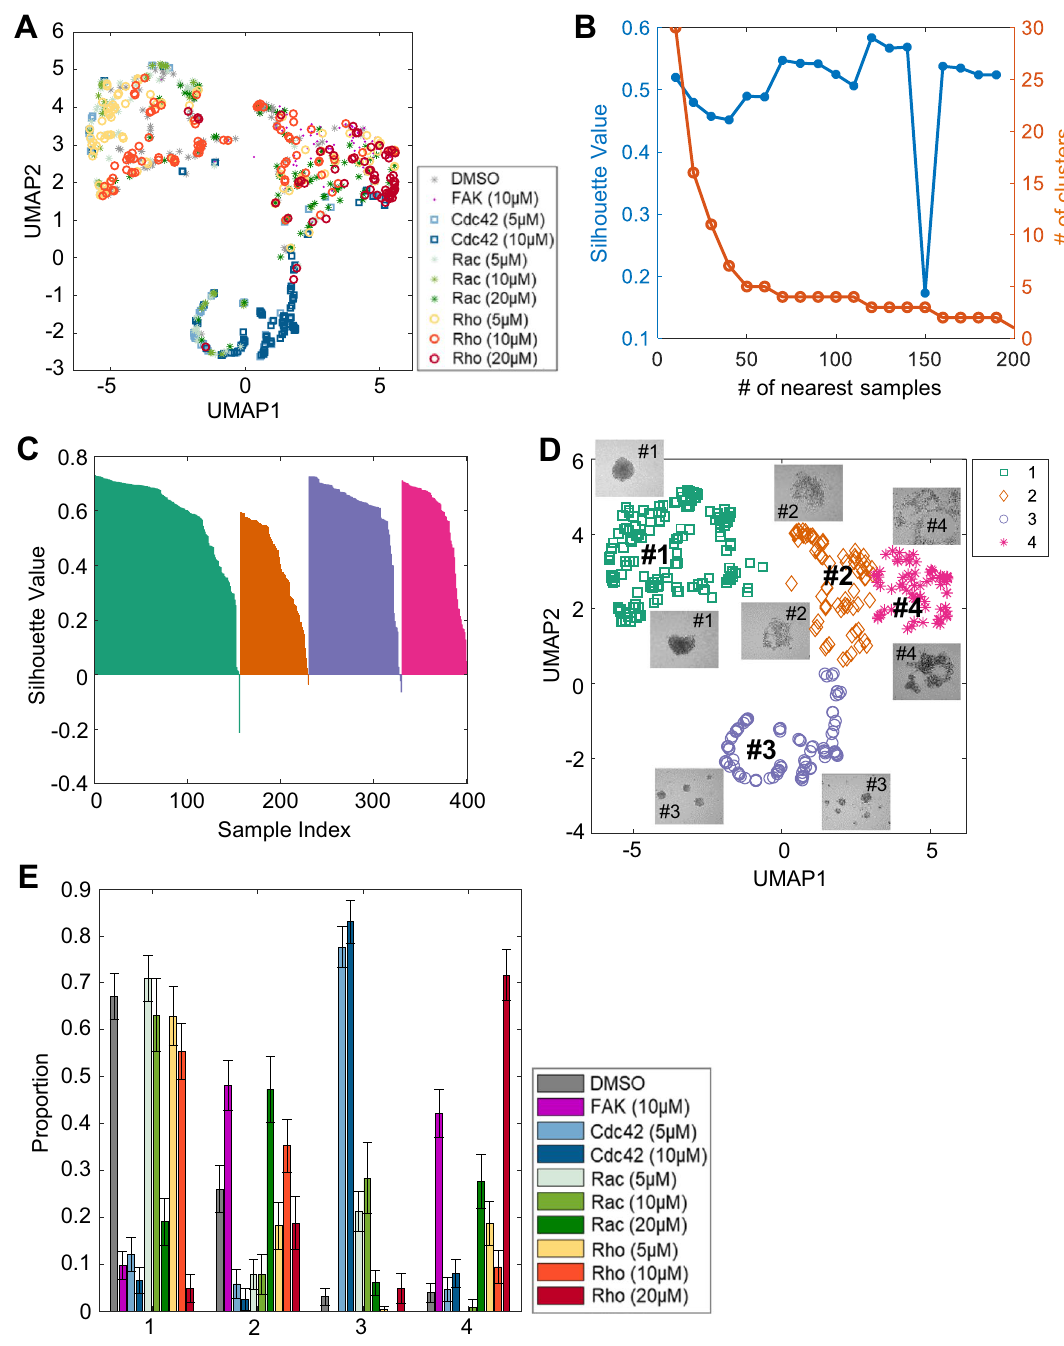
Figure 5. Initial morphological clustering analysis identifying distinct clusters in response to inhibitors of FAK, Rac, Rho, and Cdc42. ( A ) Four morphological features extracted from human VSMC spheroid images are displayed on a UMAP plot. The different colored markers are used to represent the various drug treatments: FAK (PF573228), Rac (EHT1864), Rho (Rhosin), and Cdc42 (ML141). ( B ) The silhouette values and the number of clusters on the training set were evaluated by varying the number of nearest samples. ( C ) Silhouette plots for the clustering results on the testing set. ( D ) Four morphological clusters plotted on the UMAP plot were observed based on the “roundness of the spheroid”. The different colored markers are used to represent the various morphological clusters with the drug treatments. The most representative images were overlayed on each cluster (2 images per cluster) in the UMAP plot. Clusters #1 and #3 showed spheroids with circular morphologies, and the spheroids in Clusters #2 and #4 showed noncircular and dispersed/disrupted morphologies. Only the samples in the testing set were used. ( E ) Average proportionality plot of the distribution of VSMC spheroids in each morphological cluster with the drug treatments from the repeated random splitting of training and testing sets. Only testing sets were